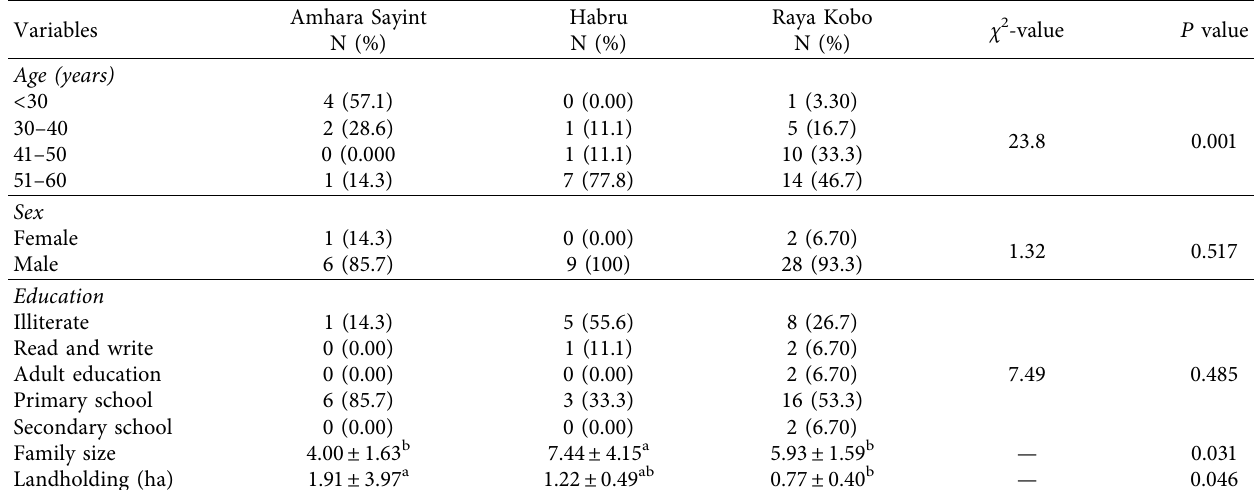
Table 1: Characteristics of households.